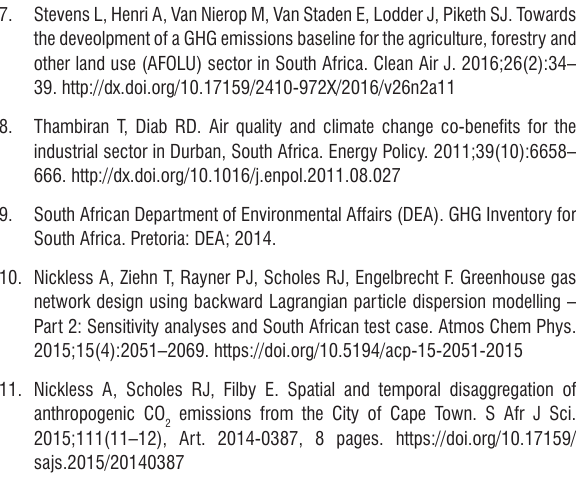
observations in the Southern Ocean between 1995 and 2013 from the Surface Ocean CO Figure 2. Gridded CO 2 of the seasonal cycle (in months) is shown; white space indicates no